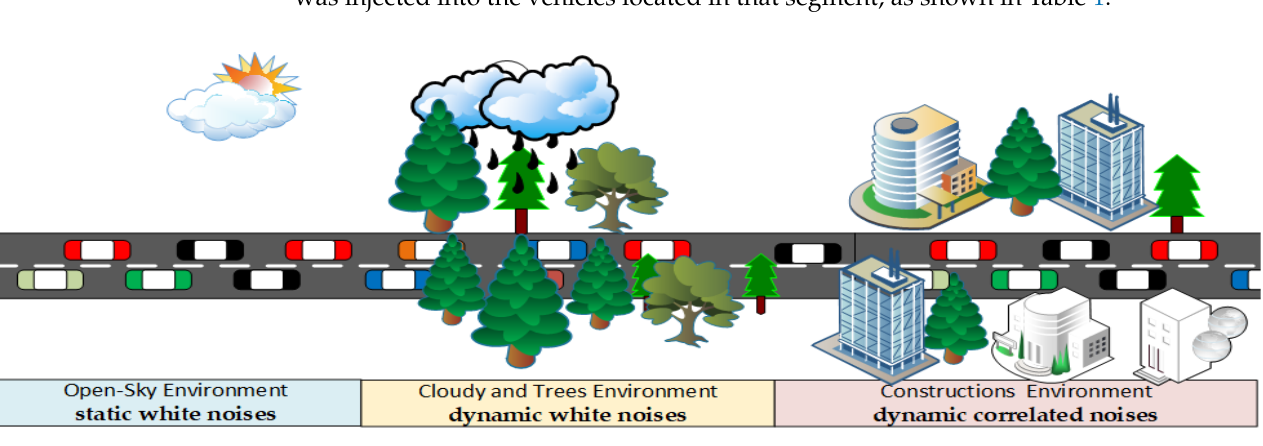
Figure 3. Road noise scenario.